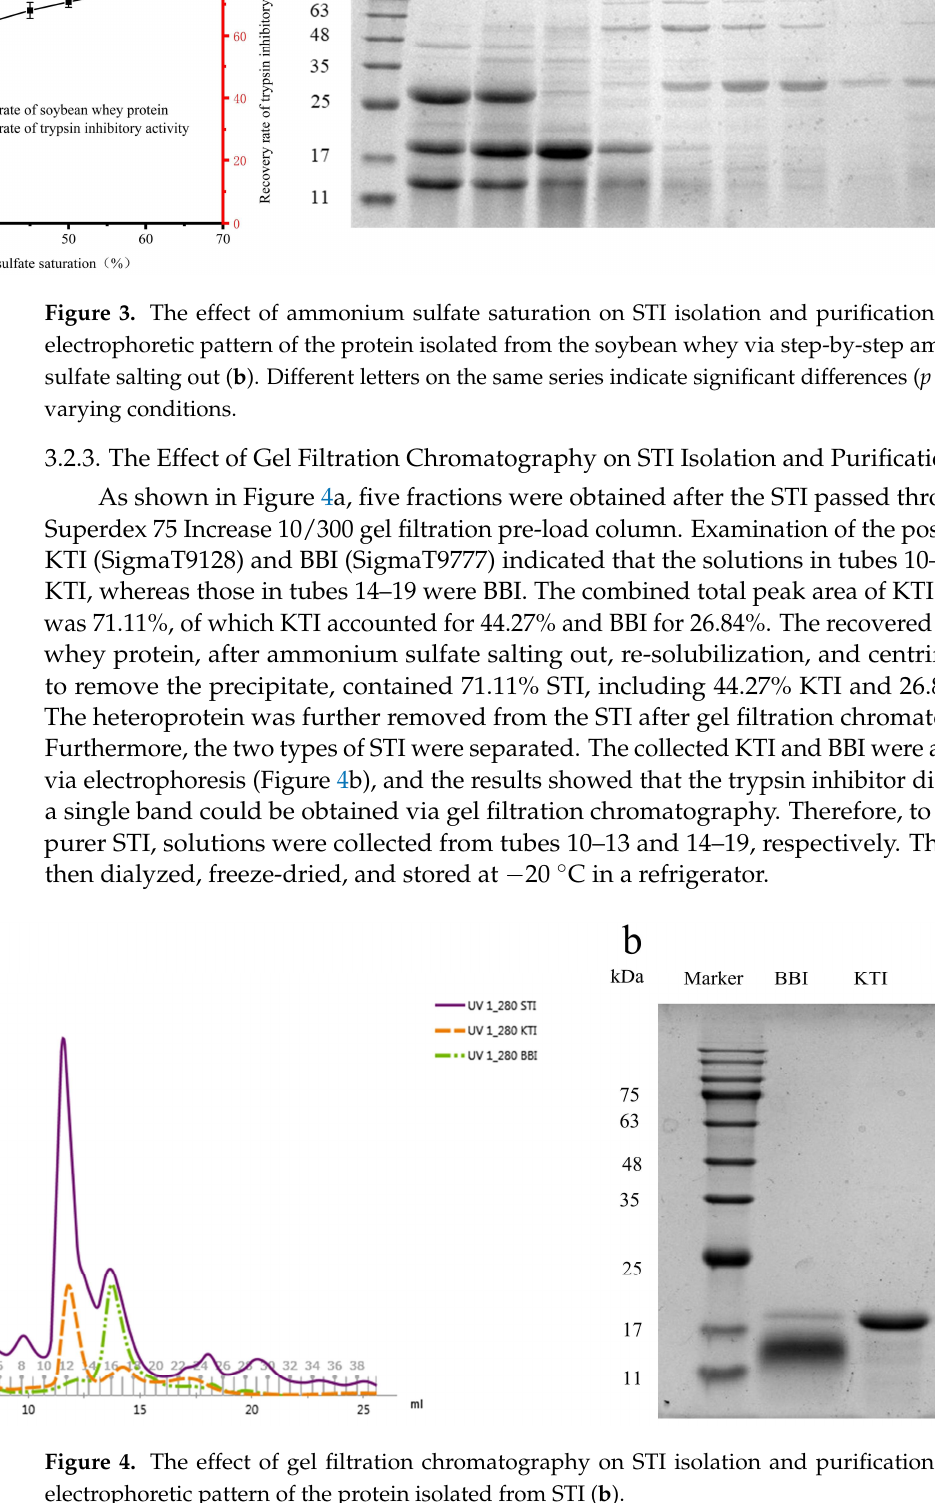
Figure 4. The effect of gel filtration chromatography on STI isolation and purification ( a ). The elec- trophoretic pattern of the protein isolated from STI ( b ).